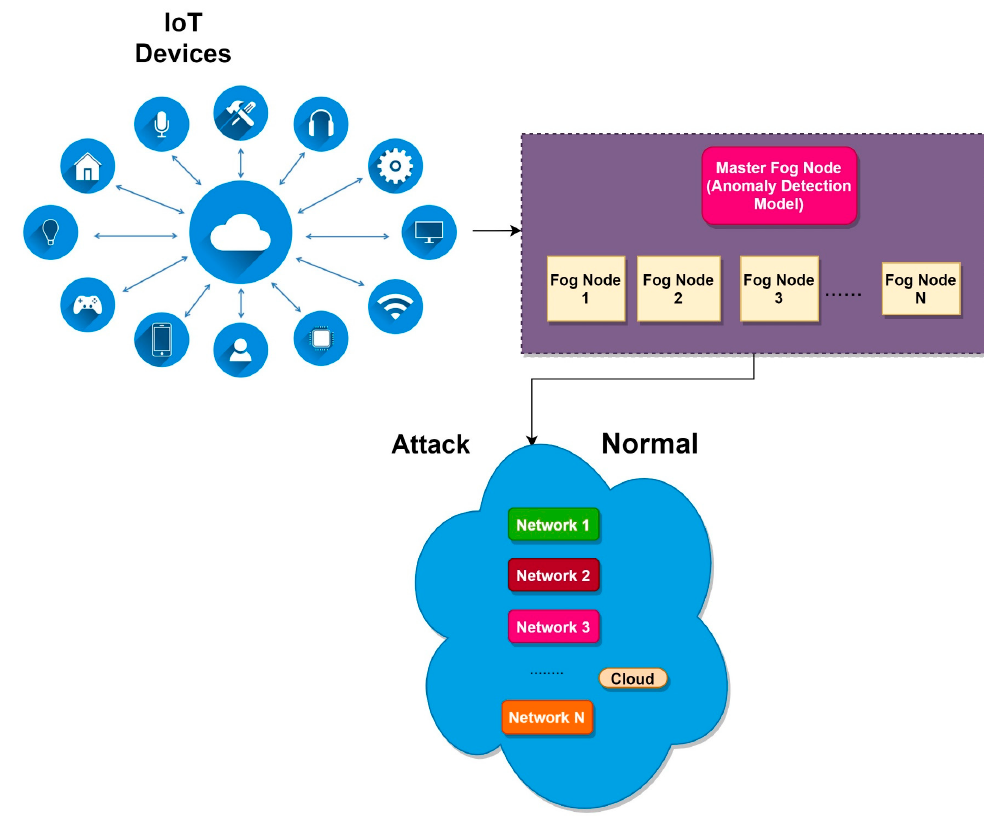
Figure 1. Implementation of the anomaly detection system in IoT systems.